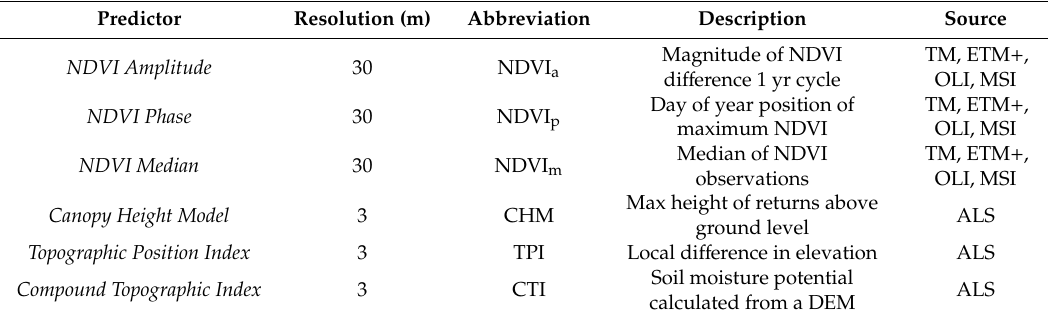
Table 1. RandomForest data inputs for classifying ash presence and absence in Minnesota, USA. Predictor